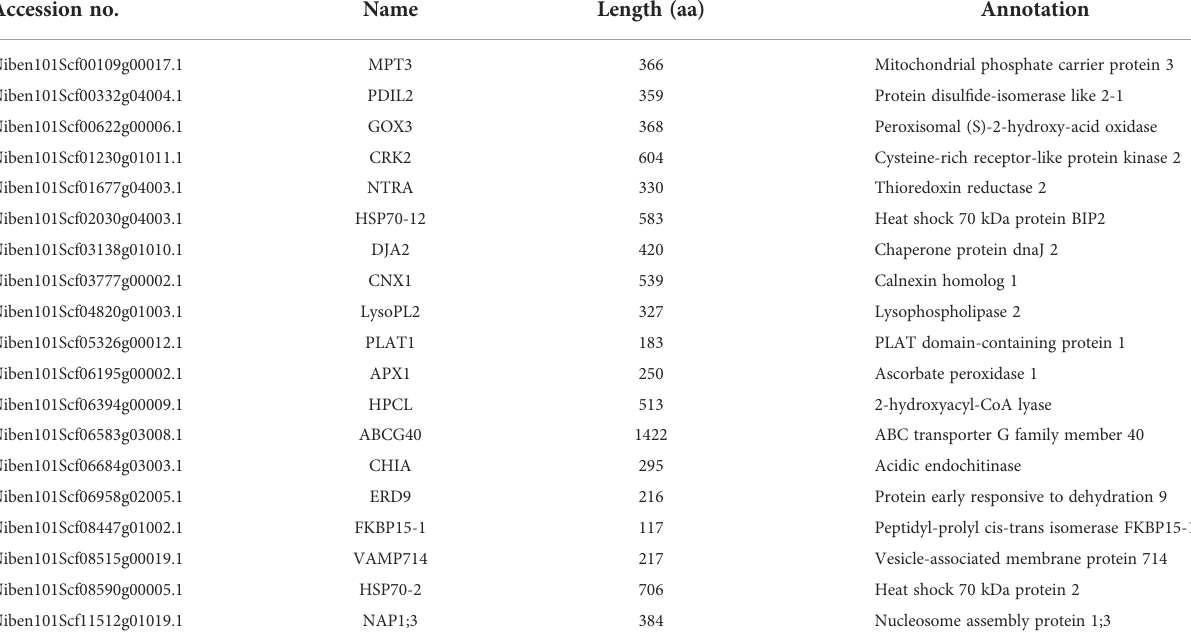
TABLE 1 Information of 19 candidate proteins in cluster 7.